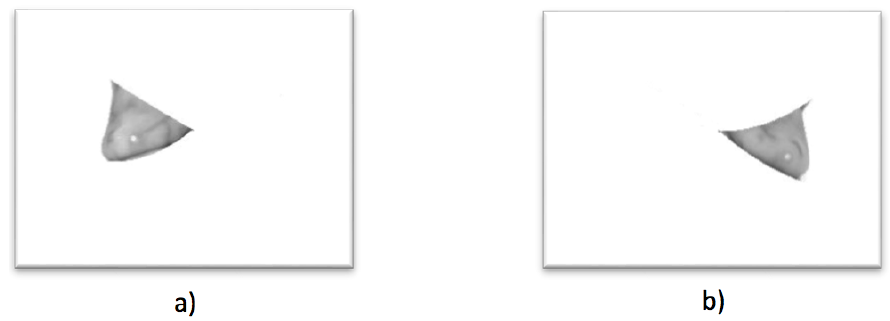
Figure 12. Segmented breast thermograms: ( a ) left; and ( b ) right